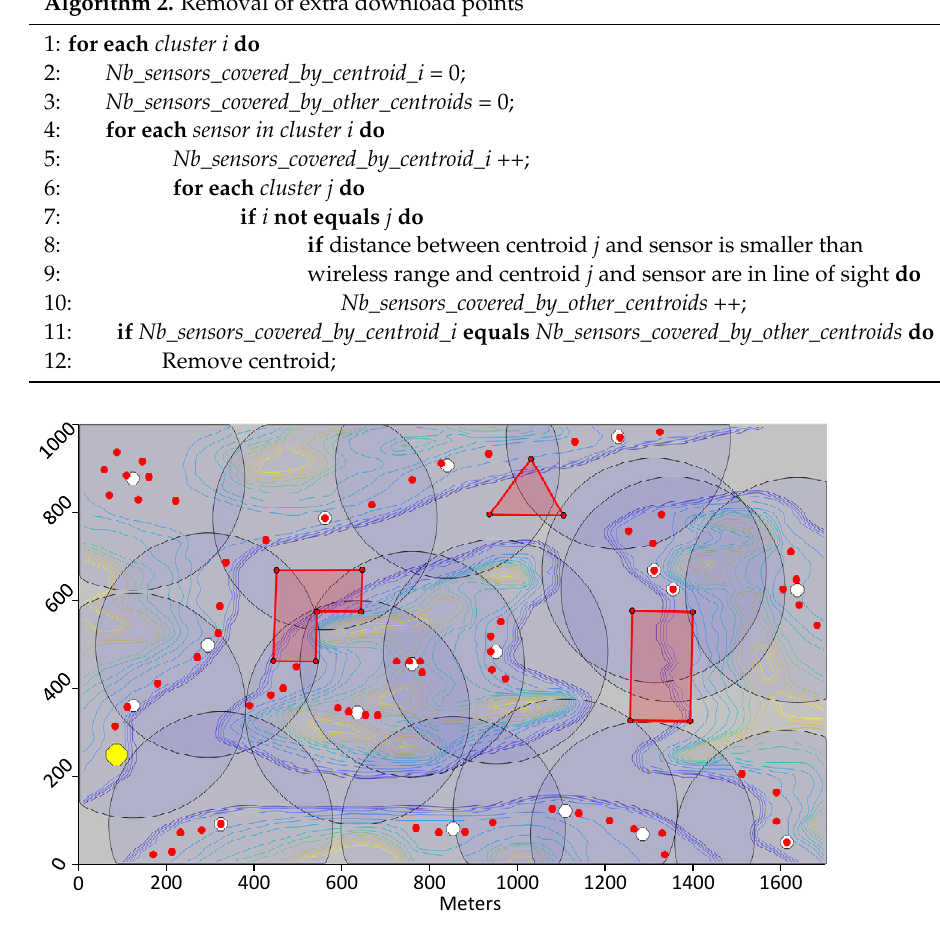
Figure 4. 1700 by 1000-m map showing 70 sensors in red strategically positioned, 15 download points in white and the starting point of the UAVs in yellow. There are also three no-fly zones represented by the red polygons.